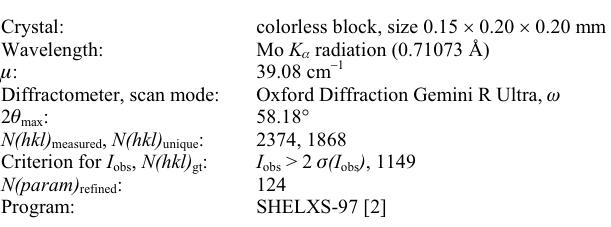
Table 1. Data collection and handling.